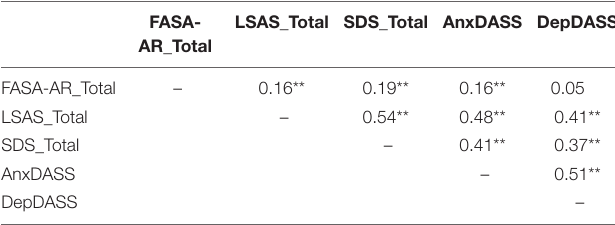
TABLE 2 | Correlation coefficients for study